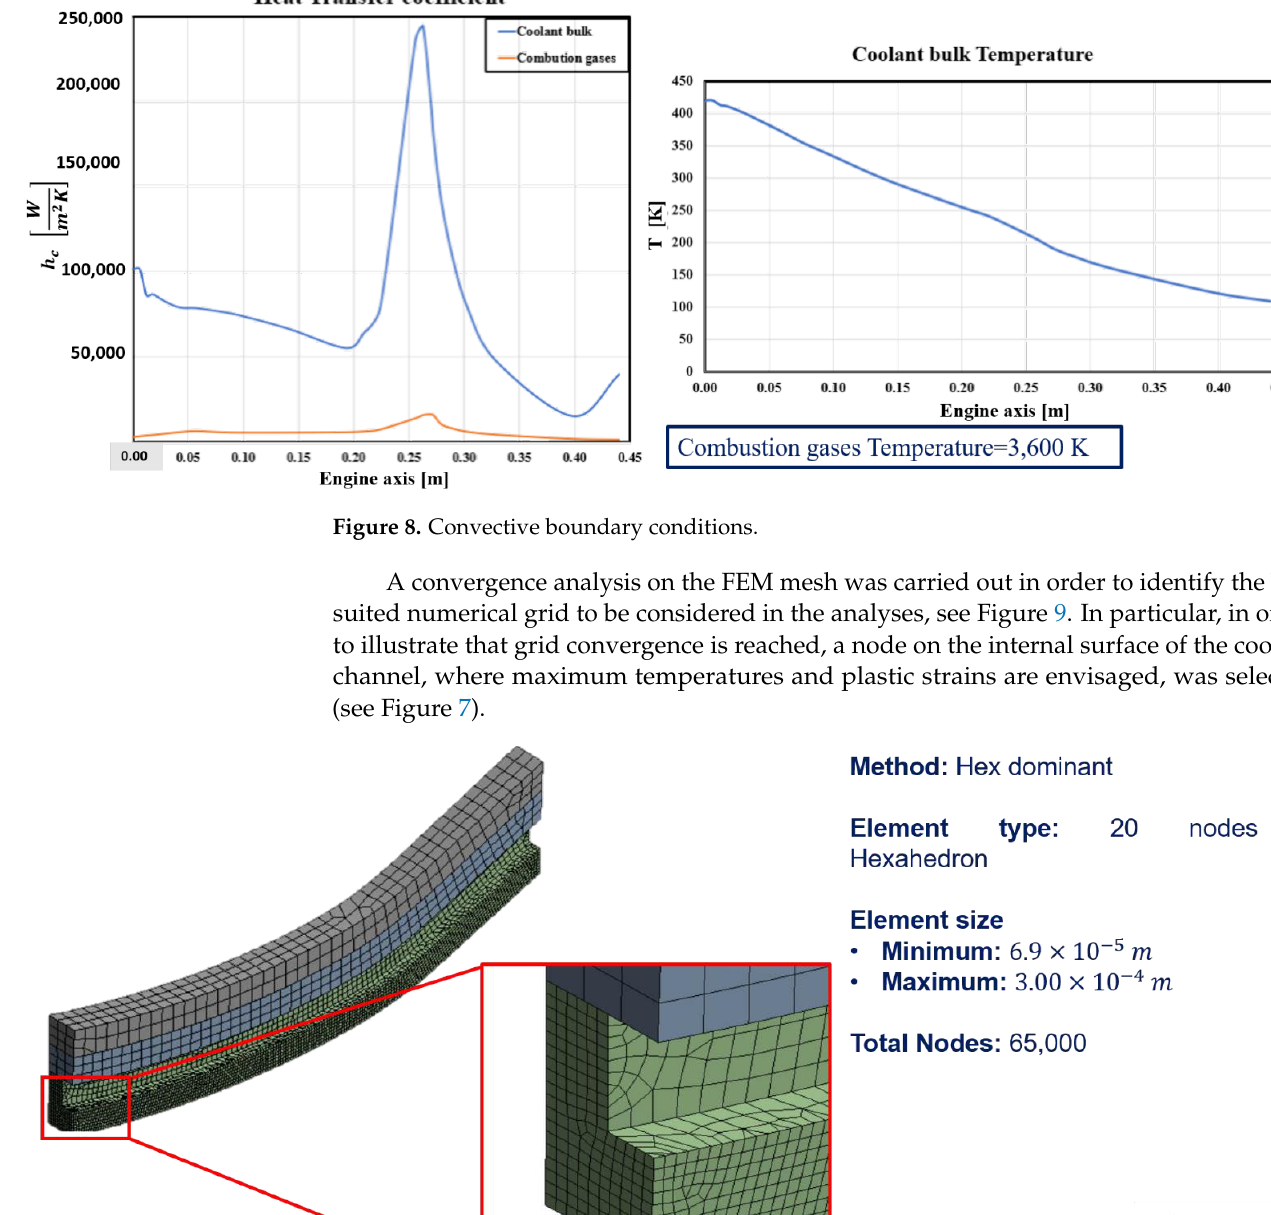
Figure 7. Thermal and structural boundary conditions.